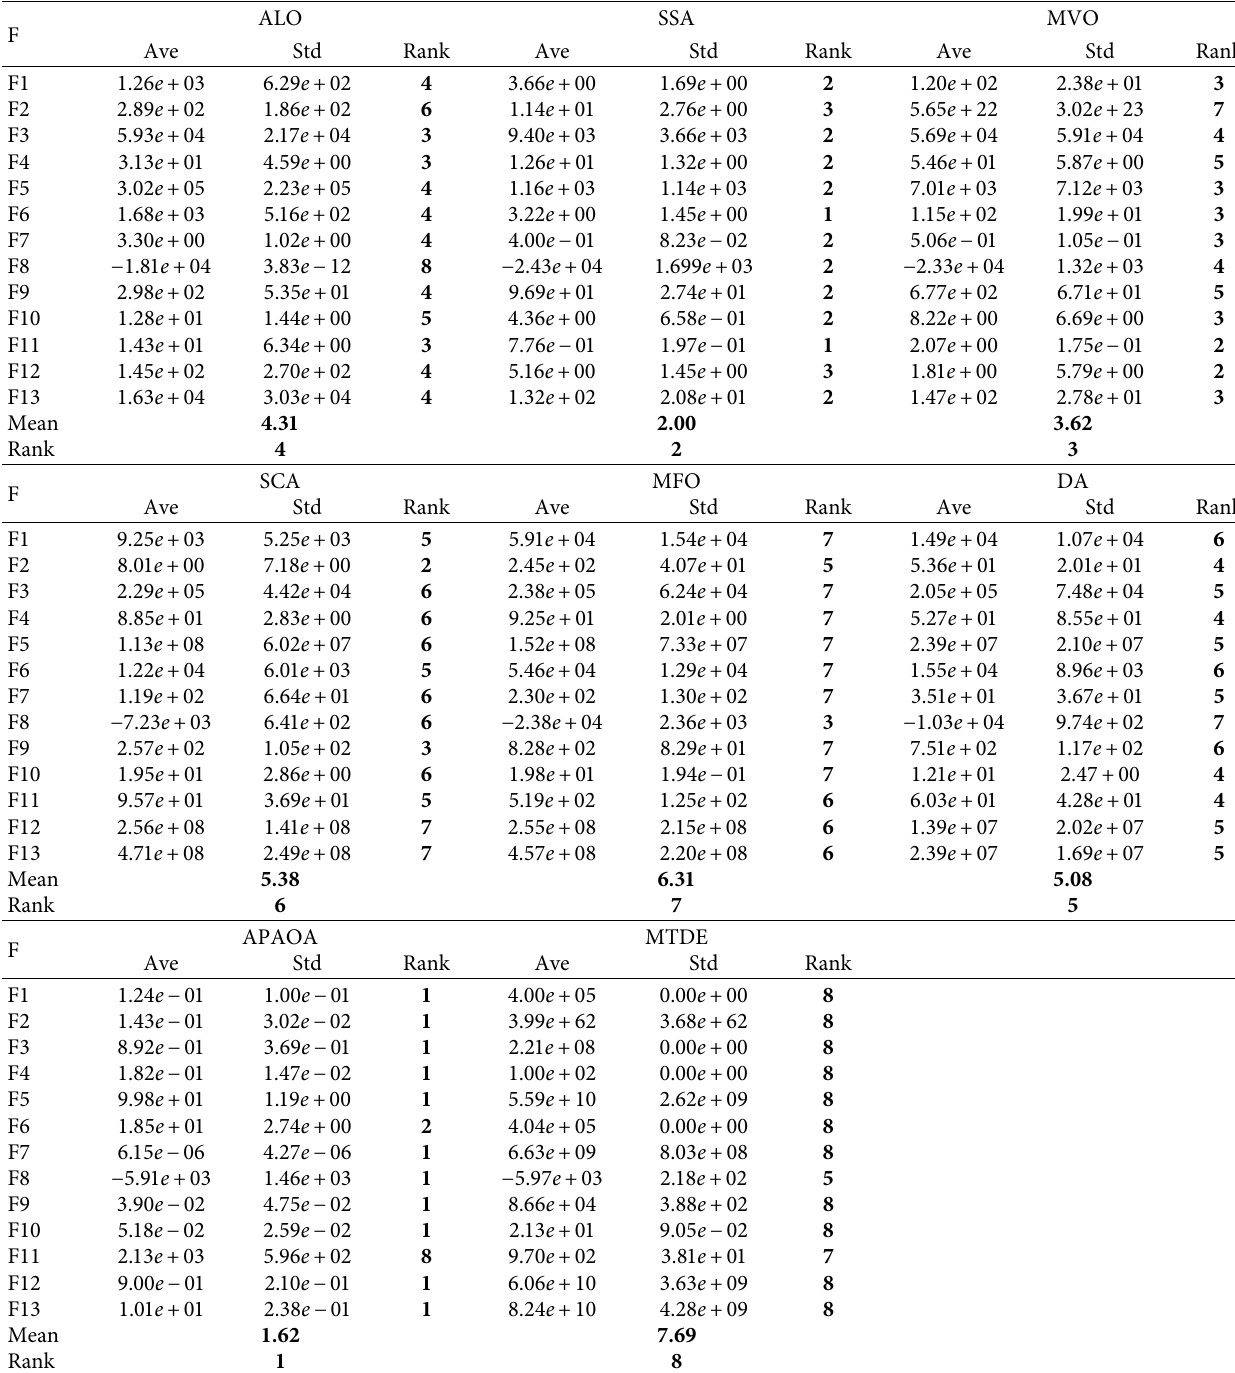
Table 8: Comparison results of popular algorithms in